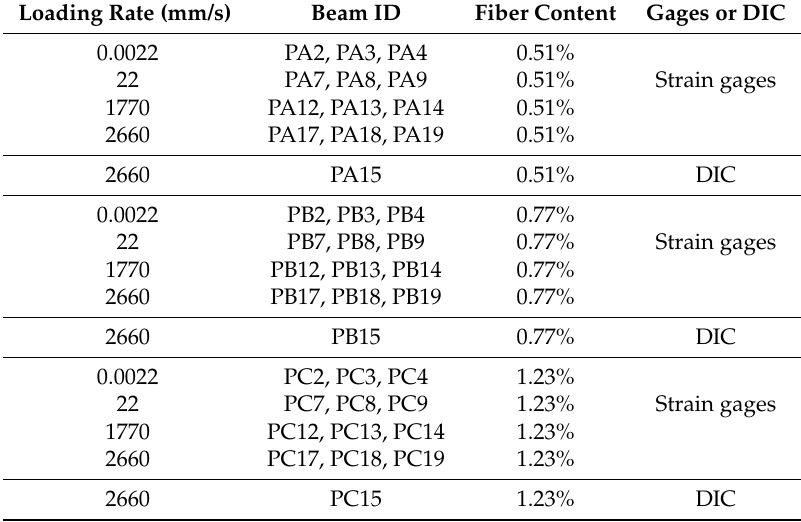
Table 2. Three-point bending tests loading rate with tested beam ID, the corresponding fiber content. The beams with glued strain gages are designed to measure P max , P ini , f R , ˙ ε i , ˙ ε ic , I 5 , I 10 , I 20 , R 5,10 , R 10,20 and V SG , whereas the three beams PA15, PB15 and PC15 were assigned to DIC analysis to measure the crack